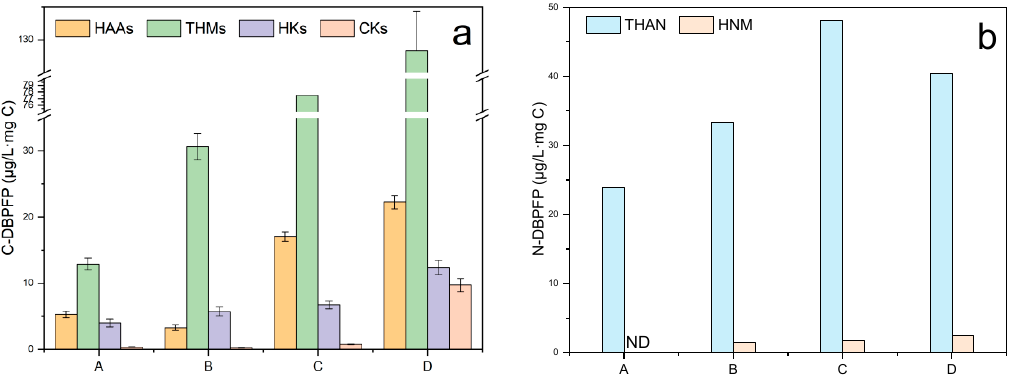
Figure 6. DBPFP of the WWTP (( a ) the formation of C-DBPFP; ( b ) the formation of N-DBPFP;) (A: influent of wastewater, B: AGC effluent, C: AAO effluent, and D: MBR effluent).